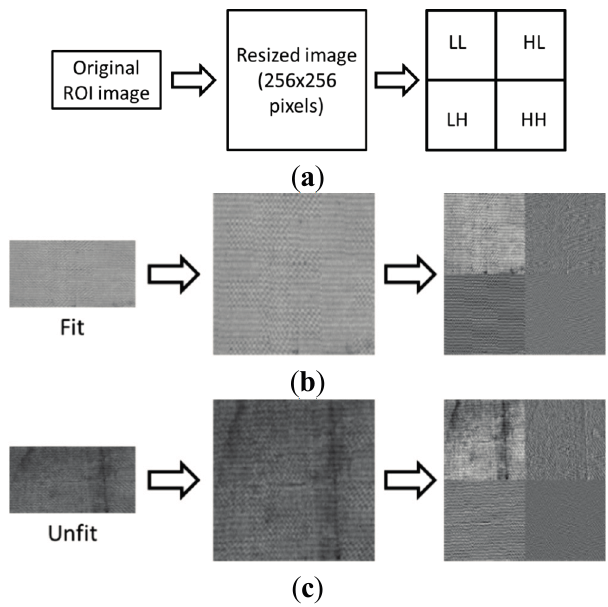
Figure 3. DWT with fit and unfit banknotes: ( a ) procedure of DWT and resulting images of DWT with ( b ) fit banknote and ( c ) unfit